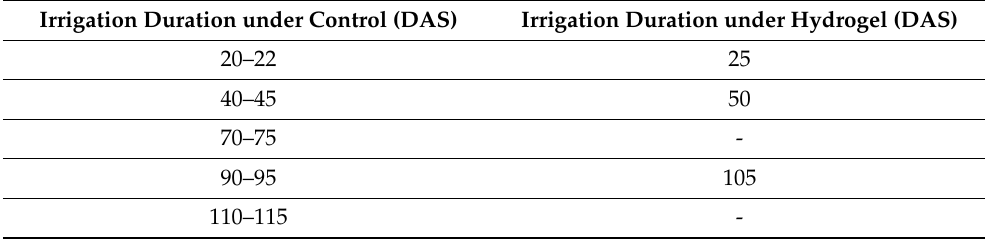
Table 2. Irrigation time interval under hydrogel and control